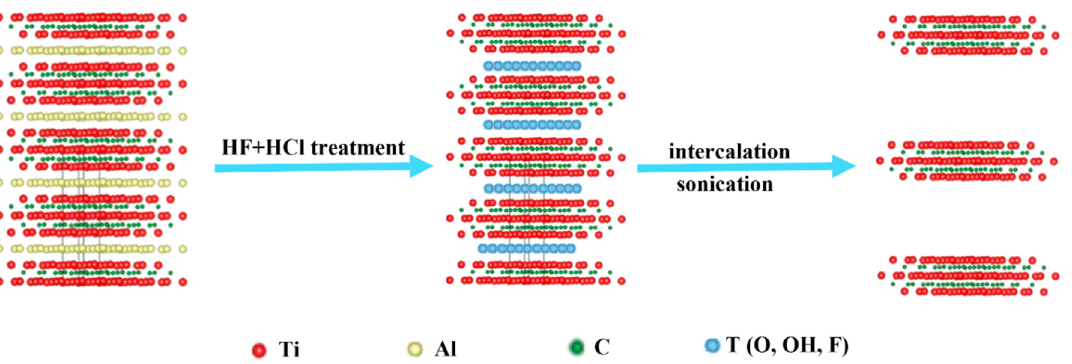
Figure 1. Schematics showing the synthesis of Ti 3 C 2 T x nanosheets by a mixed-acid (LiF + HCl) method.